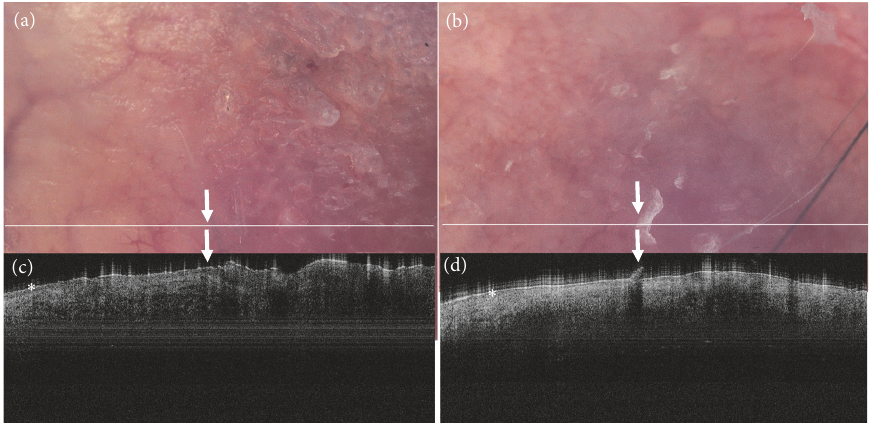
Figure 2: Dermoscopic images of the lesion acquired with the digital dermatoscopeincorporatedto the NITID device and the corresponding OCT image of Bowen’s lesion shown in Figure 1. The white line on the dermatoscopic image corresponds to the section scanned by OCT. Panels (a, b): the lesion at baseline. The left half of the OCT scan includes a healthy skin segment (control) featuring a well-defined epidermis (asterisk). At the transition of healthy skin to the lesion, the typical for Bowen’s disease thickening and disarrangement of the epidermis becomesevident(righttothearrow).Panels(b,d):thesiteofthelesionsatthe 12 th monthfollow-up.Thereisnormalizationoftheepidermisin thedermoscopicandtheOCTimages(asterisk).Thefocalhyperkeratosisevidentinthedermatoscopicimage(Panel(b),arrow)isalsoevident in the OCT image as a disruption in the epidermis (Panel (d), arrow) which, however, causes no concern as the epidermis is homogenous throughout the scanned